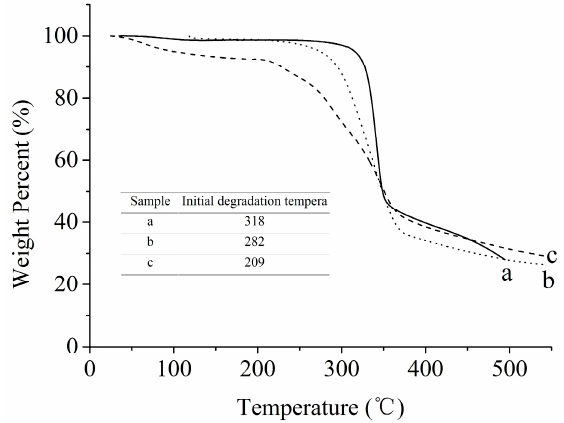
Figure 8. TGA analysis of a: the original MCC, b: the CNCs extracted with swelling − SA − catalyzed hydrolysis method at 45 °C for 5 h, and c: the extracted CNCs hydrolyzed in 65.0 wt% H 2 SO 4 at 45 °C for 5 h.